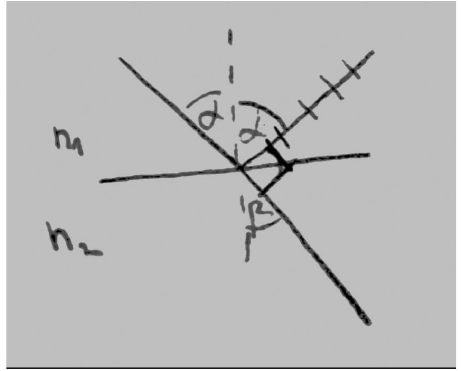
FIG. 9. The schematic representation of Brewster ’ s law, commonly found in textbooks, drawn by student